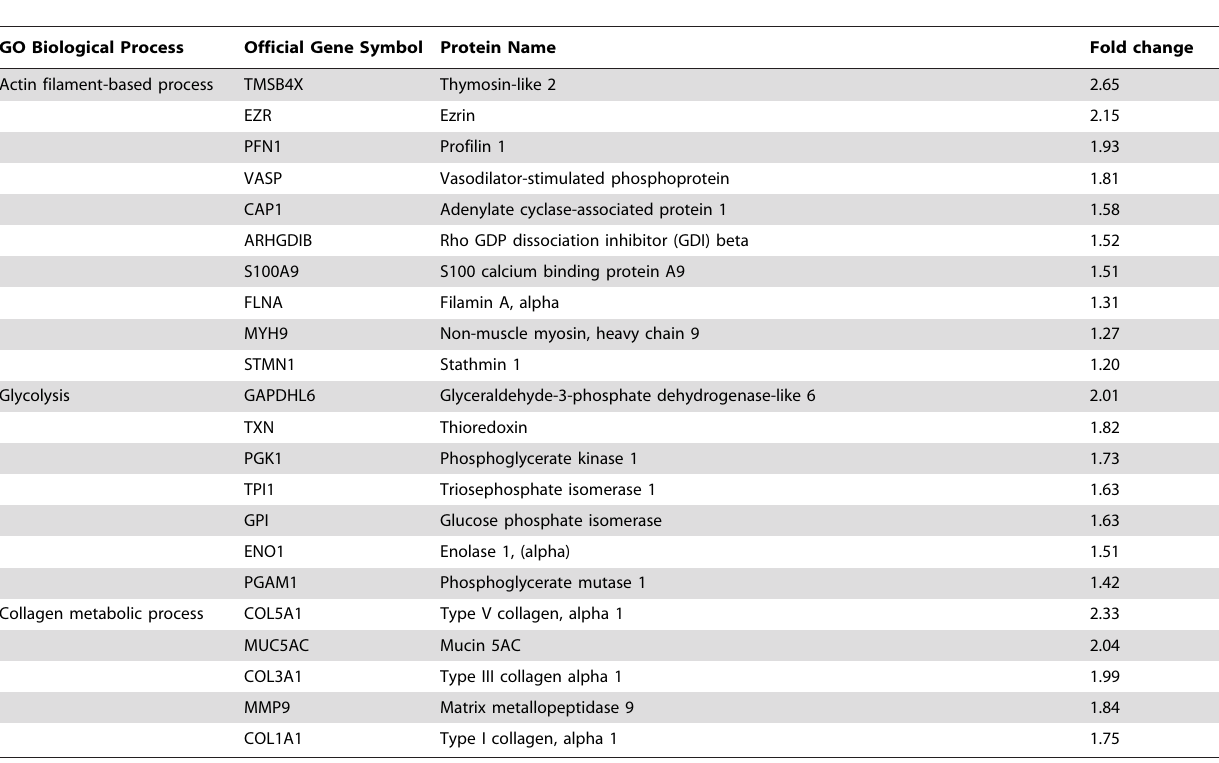
GO Biological Process Official Gene Symbol Protein Name Fold